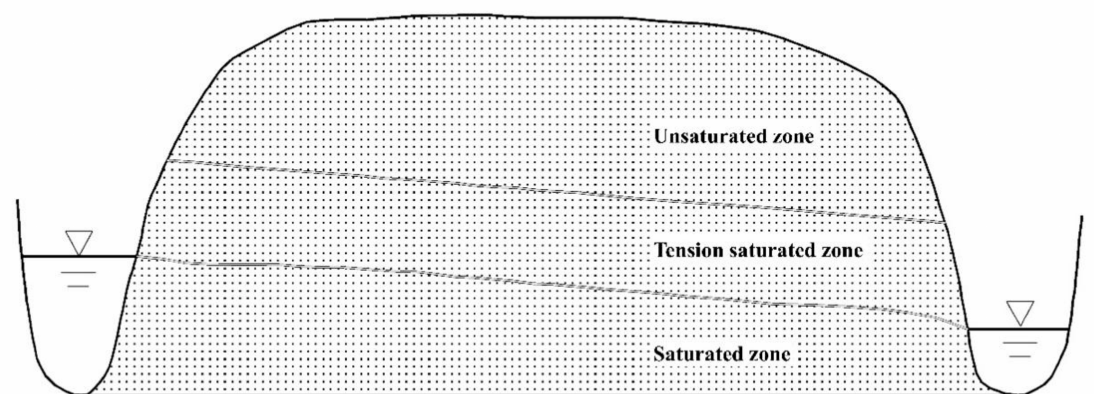
Figure 1. The conceptual interfluve model of the seepage zone. (a) The interfluve, where the aquifer media was assumed to be homogeneous and isotropic, was defined as a cuboid seepage zone that lay between two parallel rivers